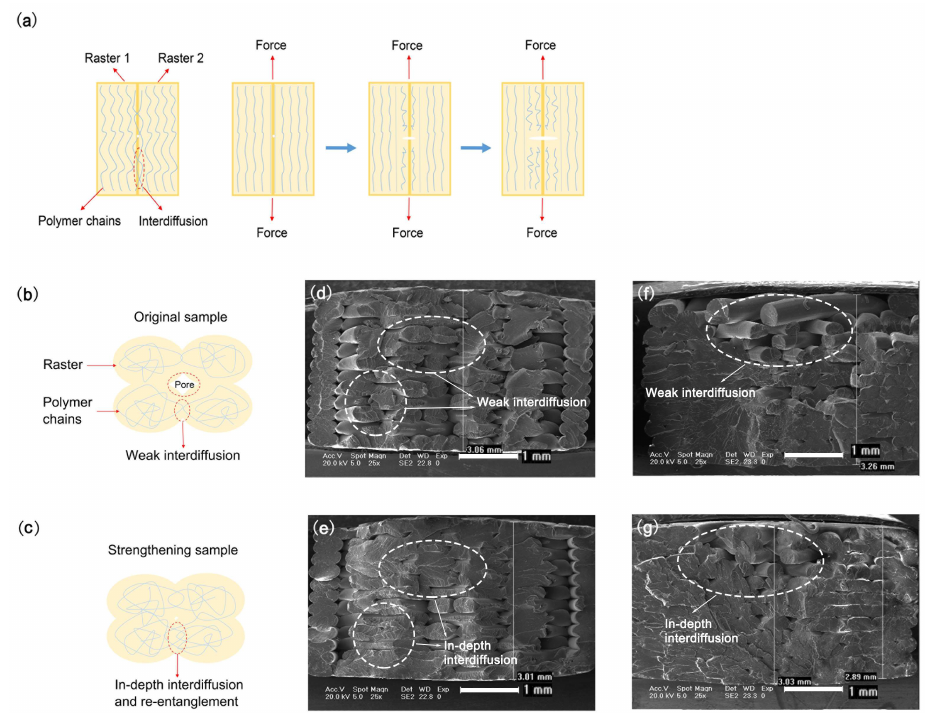
Figure 3. Schematic illustration of tensile breakage of: 3D printed samples ( a ); microcosmic interface of original ( b ); and ultrasonic-strengthened ( c ) samples. SEM images of fractured surfaces: original ABS samples ( d ); ultrasonic-strengthened ABS samples ( e ); original PLA samples ( f ); and ultrasonic-strengthened PLA samples ( g ).